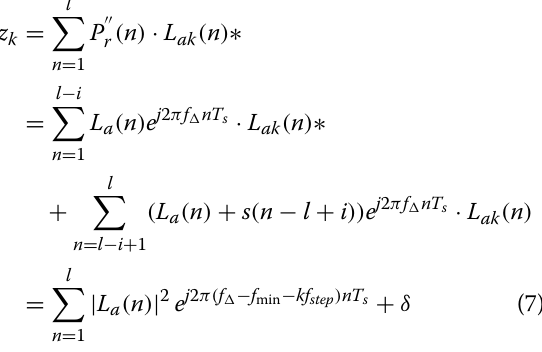
Duration Period Average T L = 2 T FFT = 6.4us